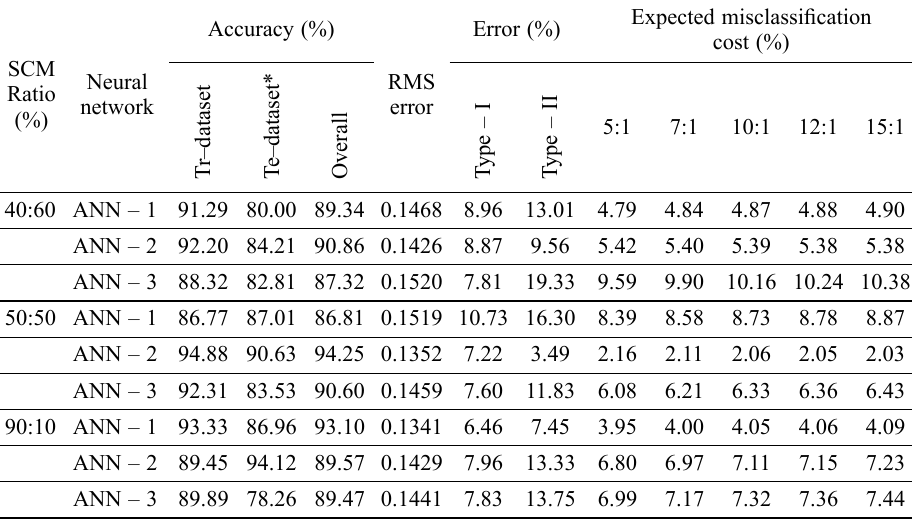
Table 3. Performance obtained by the Australian